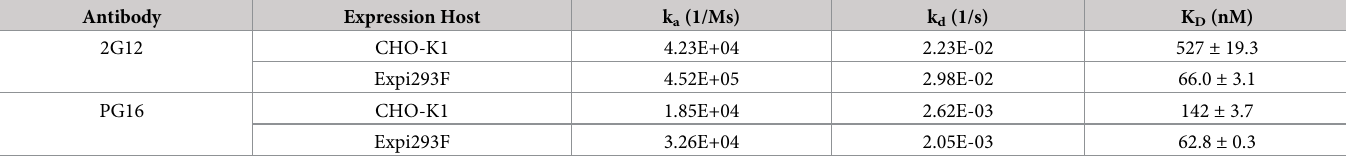
Table 3. Binding of bNAbs 2G12 and PG16 to immobilized CO6980v0c22 gp145. Antibody